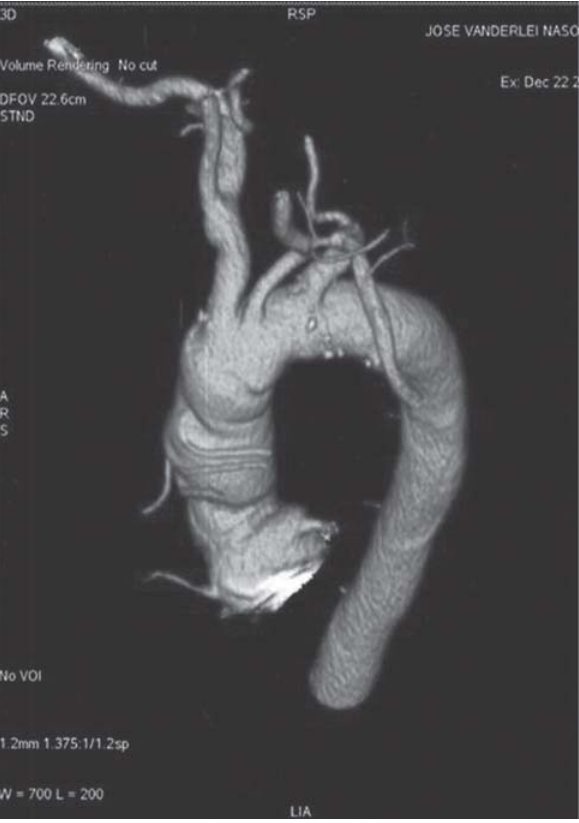
Fig. 2 - Correção da dissecção crônica tipo A em paciente revascularizado com tubo de pericárdio bovino liso e implante de prótese metálica em posição